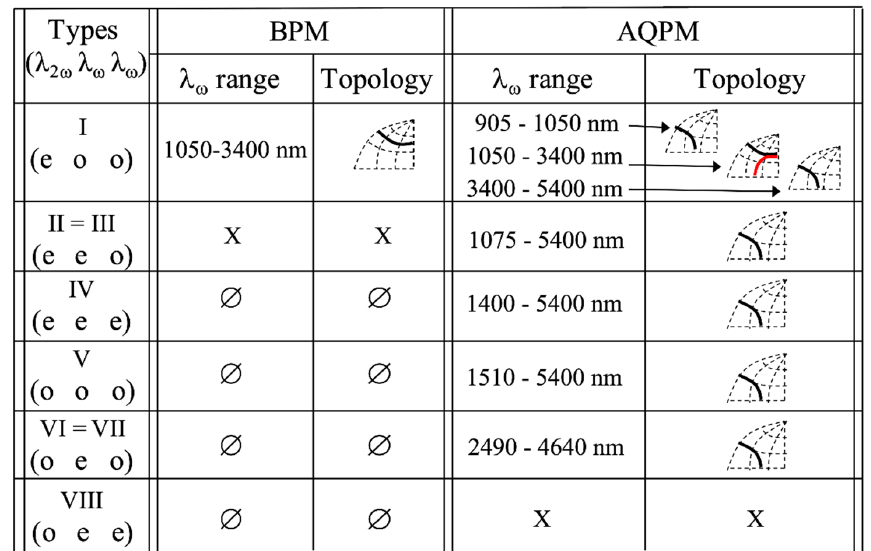
Figure 9. Comparison between the spectral ranges of BPM and AQPM topologies in 7%MgO:PPLN with a grating period of Λ =15 µm. The black cones correspond to scheme-A and the red one to scheme-B. ( o ) and ( e ) denote the ordinary and extraordinary polarizations, respectively. λ ω and λ 2 ω are the fundamental and second-harmonic wavelengths, respectively. X means that there are no BPM or AQPM solutions using the wavelength dispersion equations of the refractive indices of 7%MgO:PPLN in Ref. [28]. The symbol ∅ means that BPM types are not allowed.